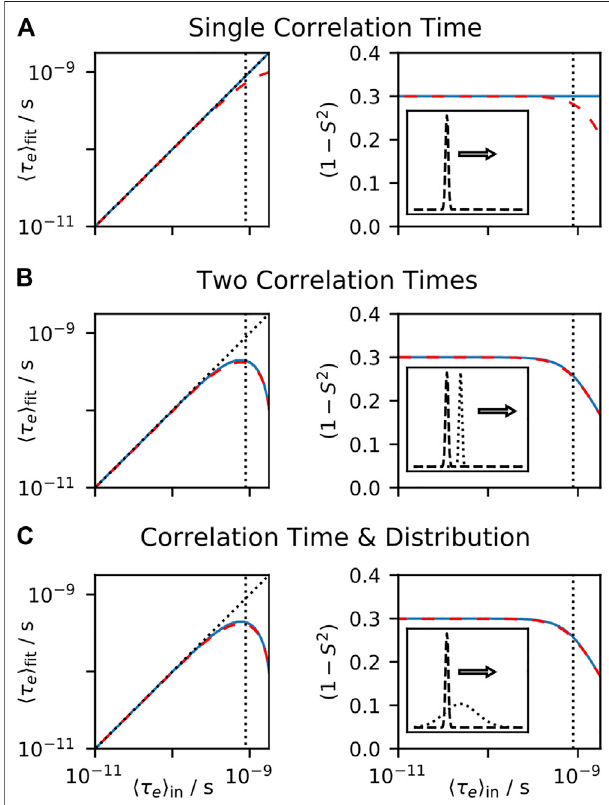
FIGURE 3 | Model-free fi t parameters as a function of input parameters. For each plot, a data set is calculated, using the experiments found in from Table I of Lipari and Szabo (1982b), and the resulting rate constants are fi t using the model-free approach, with the resulting 〈 τ e 〉 fit and (cid:10) 1 − S 2 (cid:11) shown on the left and right, respectively. For all plots, the tumbling correlation timeis τ M (cid:2) 4 nsand (cid:10) 1 − S 2 (cid:11) (cid:2) 0.3.Onecorrelationtimeoftheinternalmotion is varied, and we plot 〈 τ e 〉 in on the x -axis. In each plot, we fi t using the full spectral density (blue, solid, see Eq. 6 ) and using a linear approximation (red, dashed, see Eq. 5 ). In (A) , the input correlation function only has a single correlation time. In (B) , one correlation time is fi xed to 10 ps, and the second correlation time is swept. In (C) , a log-Gaussian distribution ( μ (cid:2) 10 ps, σ (cid:2) 0.75orderofmagnitude)iscombinedwithacorrelationtimethatisvaried(with total amplitude equal). On the left plots, black dotted lines indicate where the inputvalue, 〈 τ e 〉 in ,matchesthe fi t, 〈 τ e 〉 fit .Inallplots,verticalblackdottedlines indicate where ω 〈 τ e 〉 in (cid:2) 0 . 5 for ω /2 π (cid:2) 90 MHz, where this frequency corresponds to the highest fi eld used for the data